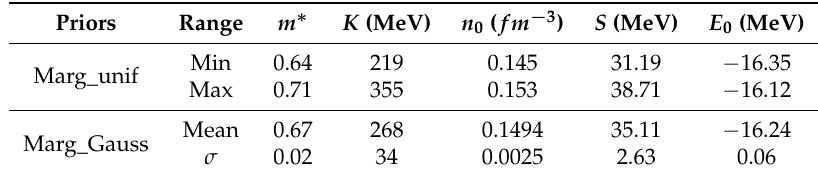
Table 1. The ranges for the nuclear matter properties for the two priors adopted in this work and extracted from Refs.